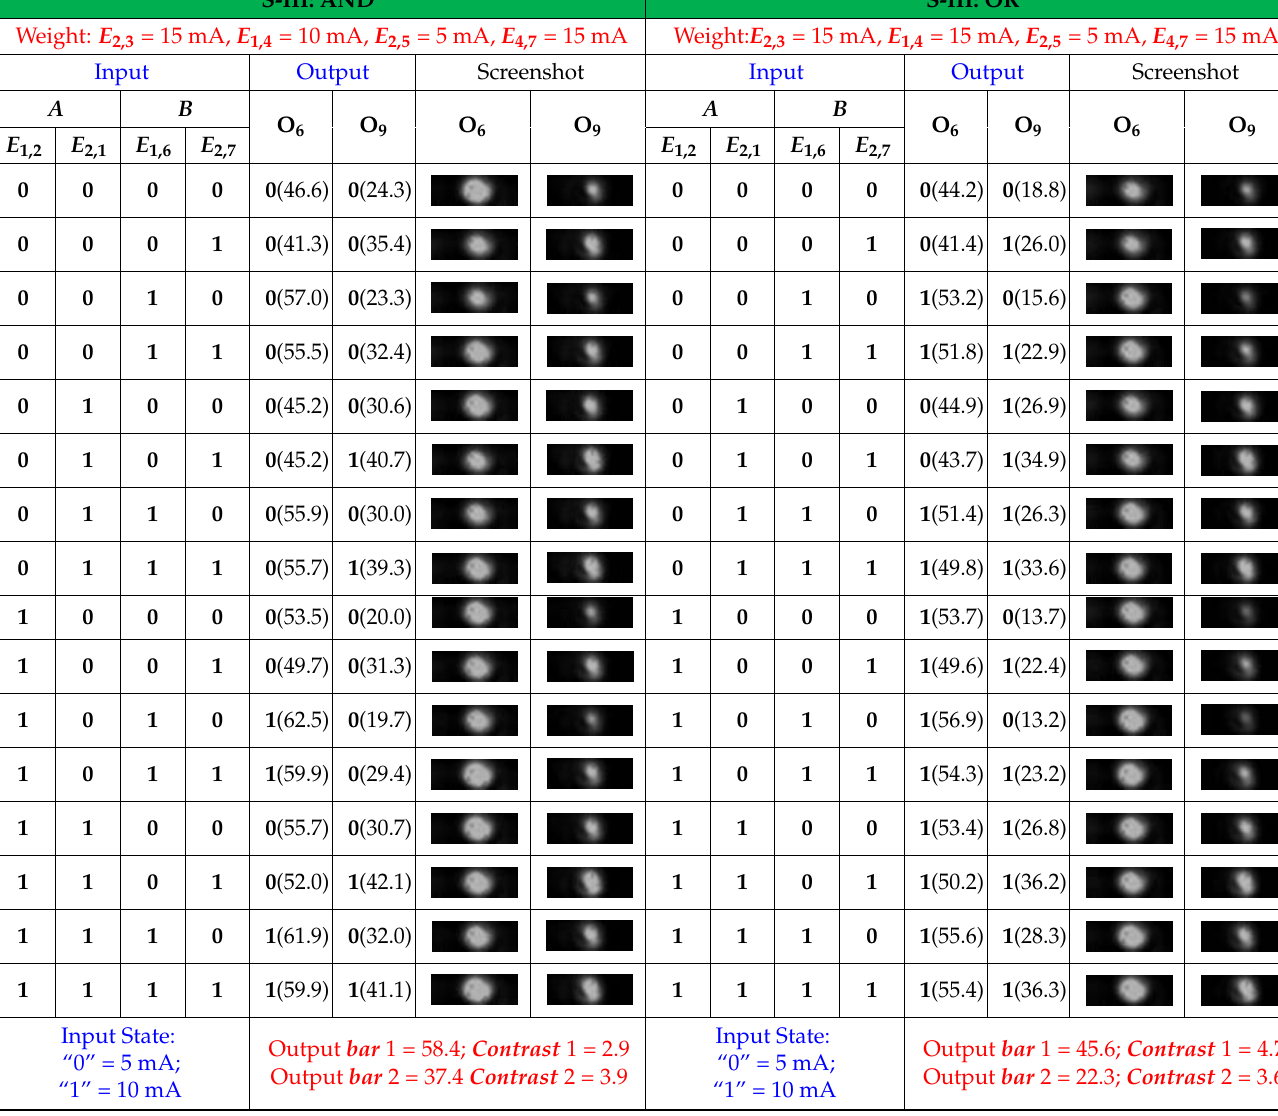
Table 3. AND and OR gate settings of S-III . [Input- = , Weight- ∀ , Output- = ] . S-III: AND S-III: